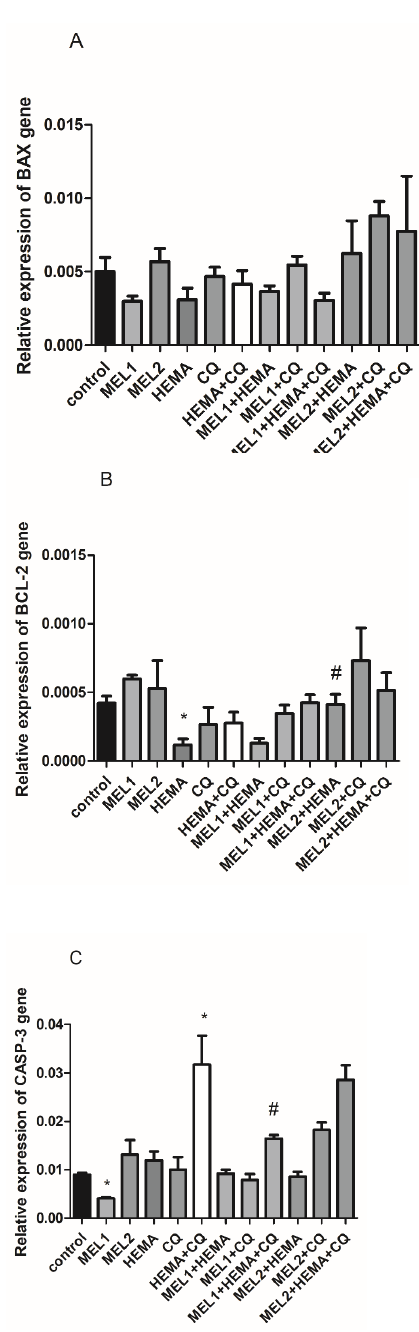
Figure 3. HEMA- and/or CQ-induced effects on BAX ( A ), BCL-2 ( B ), and CASP3 ( C ) gene expression levels in human dental pulp cells in the presence of melatonin (24 h). Each graph bar represents the mean ± SD of four experiments. * p < 0.05 chemical vs. control; # p < 0.05 chemical with melatonin vs. without melatonin. BAX—BCL-2-associated X-protein; BCL-2—B-cell lymphoma-2; CASP3—caspase- 3; MEL1 (0.1 mM) and MEL2 (1 mM)—melatonin; HEMA—2-hydroxyethyl methacrylate (5 mM); and CQ—camphorquinone (1